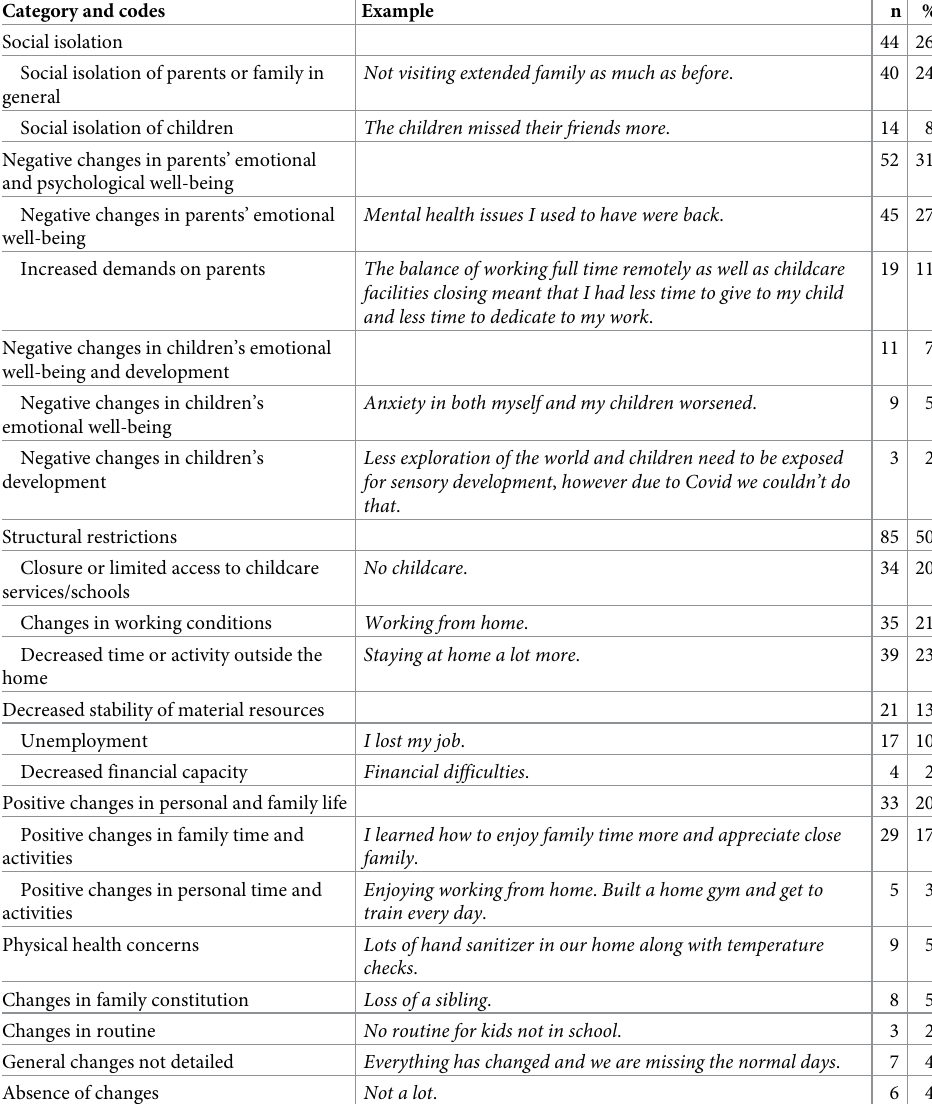
Table 1. Codes and categories within changes related to the Covid-19